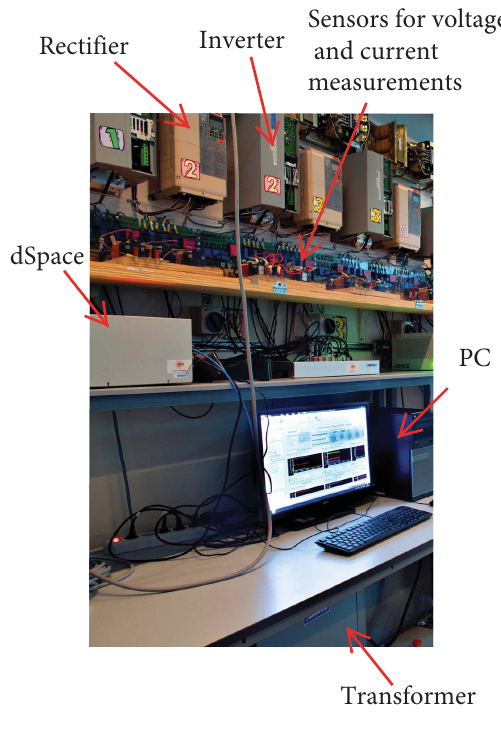
Figure 5. Experimental